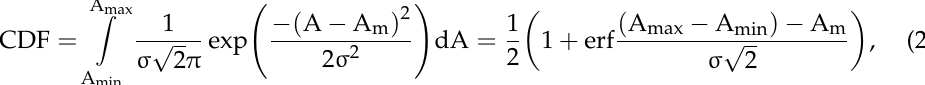
Table 1. Specific surfaces and parameters of two model Gaussian distributions that make up the total distribution characterizing the samples reduced and heated in hydrogen at various temperatures in the range of 500–700 ◦ C.